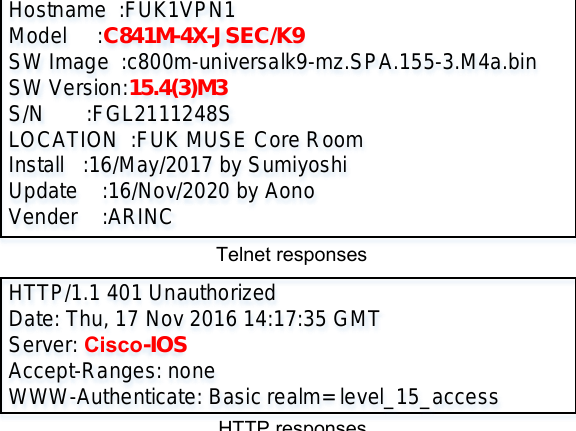
Figure 1. Examples of protocol responses.